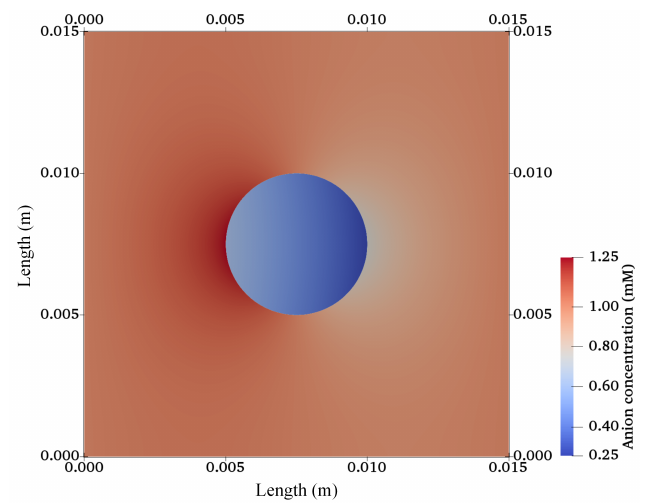
Figure 8. Anion concentration profile for a hydrogel scaffold immersed in solution.